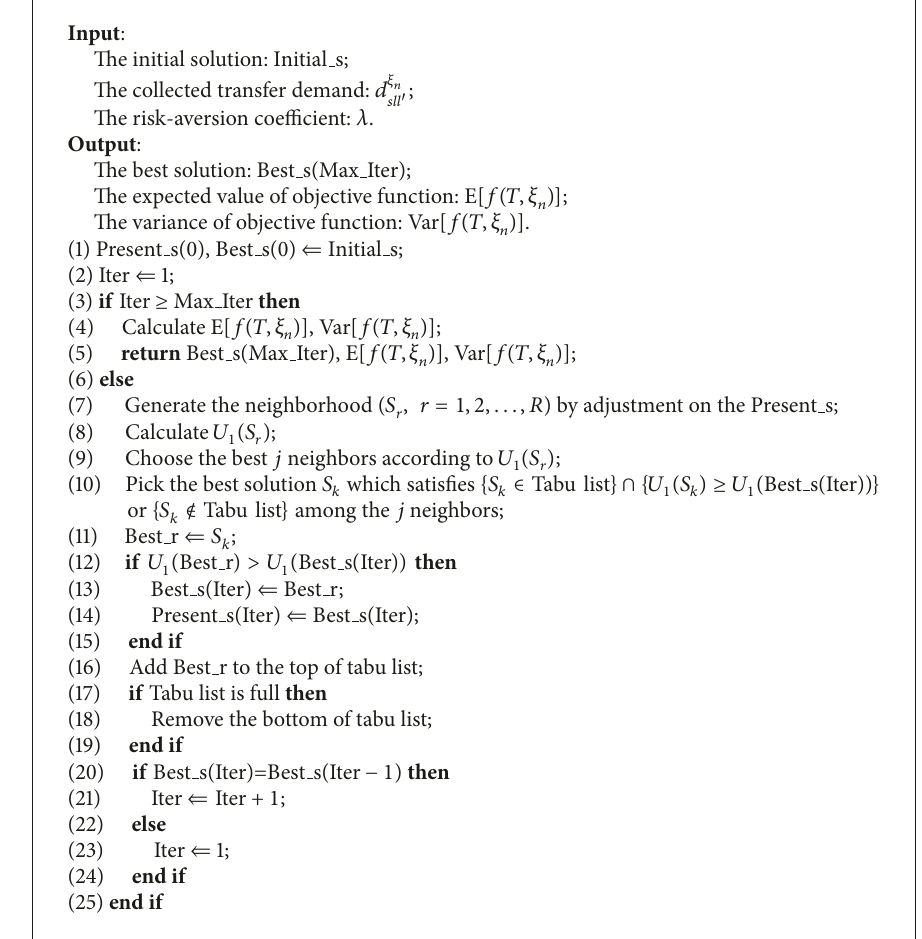
Algorithm 1: TS algorithm